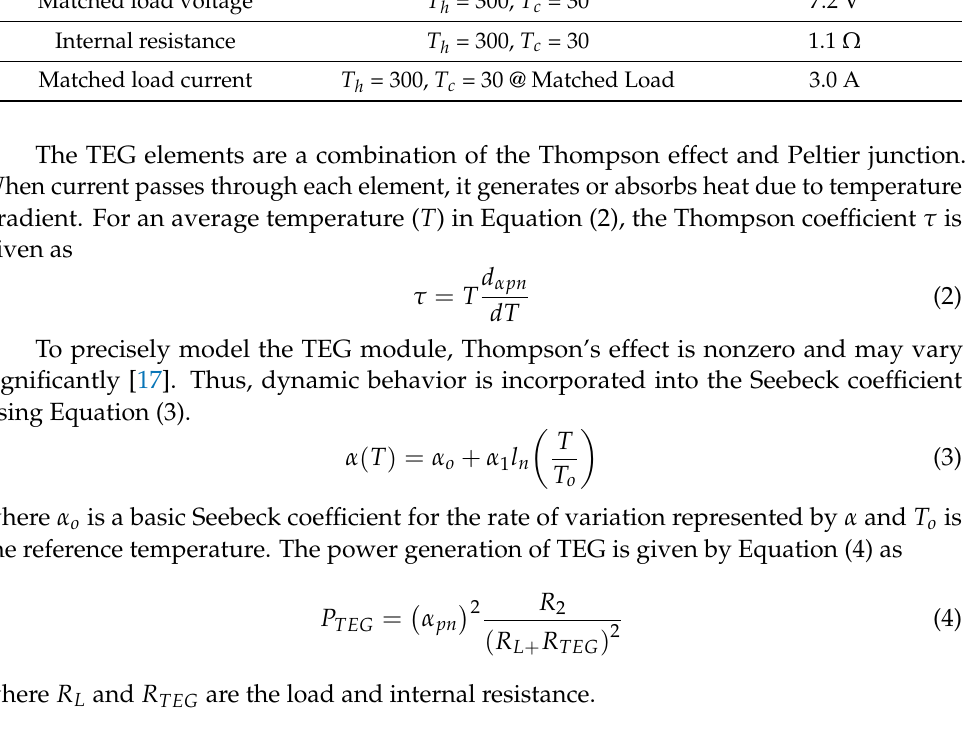
Table 1. Electrical characteristics of TEG Module (TE-MOD-22W7V-56). Parameter Conditions Value Power 22 W Open-circuit voltage Matched load voltage Internal resistance Matched load